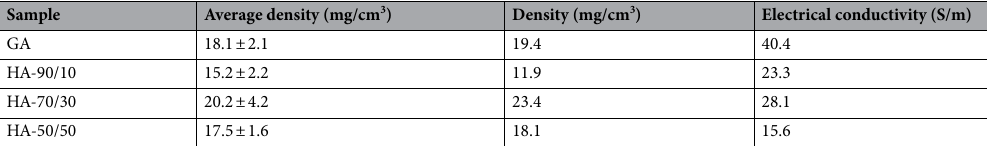
Table 2. The average density of the samples for all cases. In the second column the density of specific samples for which the electrical conductivity was measured and is given the last column. The error values represent the standard deviation of the statistical analysis applied on the measured densities of the samples.